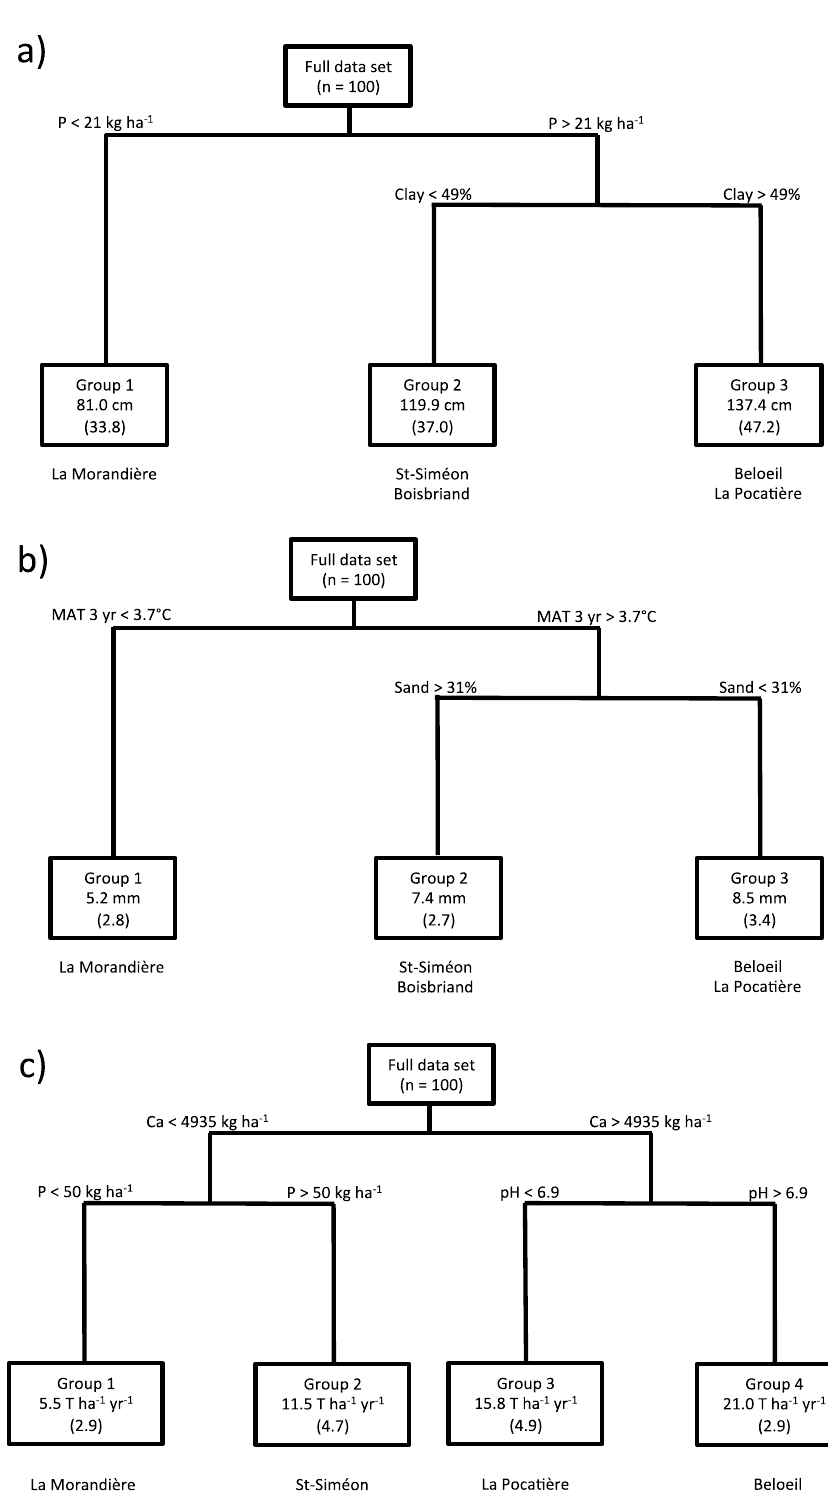
Figure 6. Regression tree model for stem height ( a ), stem diameter ( b ), and biomass yield ( c ) in the three-year rotation willow SRC. Ca, soil exchangeable calcium; Clay, soil clay content; MAT, mean annual temperature; P, soil extractible phosphorus; pH, soil pH; Sand, soil sand content. Splitting values are indicated along the branches, and boxes indicate terminal node mean (± standard error).